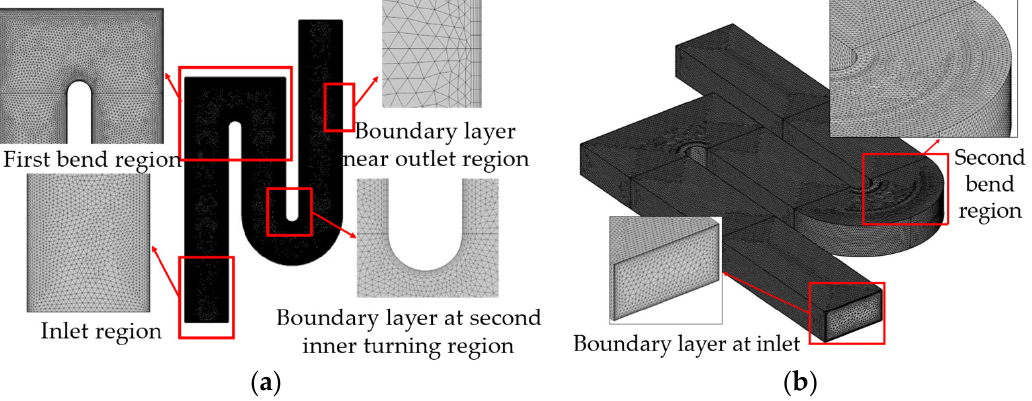
Figure 5. ( a ) The mesh system for 2D model validation; ( b ) mesh system in the 3D model.